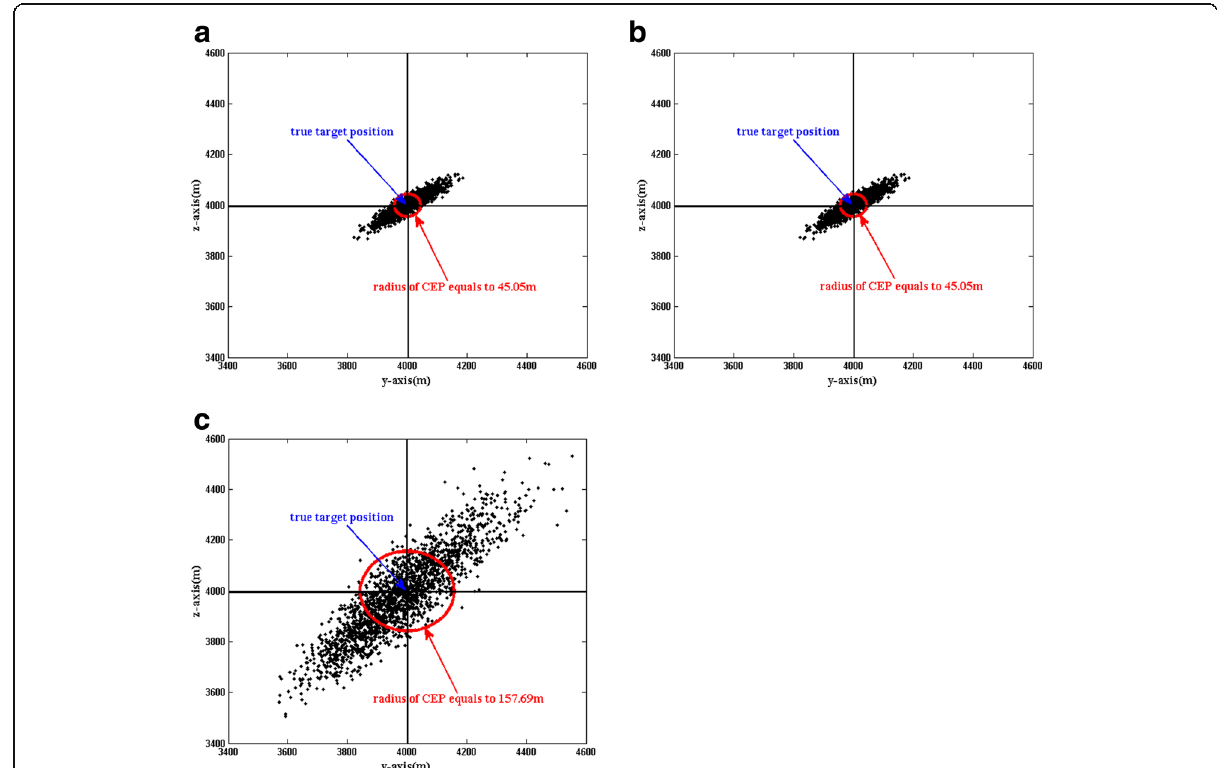
Fig. 5 Scatter plots of the source location estimates in the y – z plane. a Location estimation results for algorithm I in the y – z plane. b Location estimation results for algorithm II in the y – z plane. c Location estimation results for the TWLS algorithm in the y – z